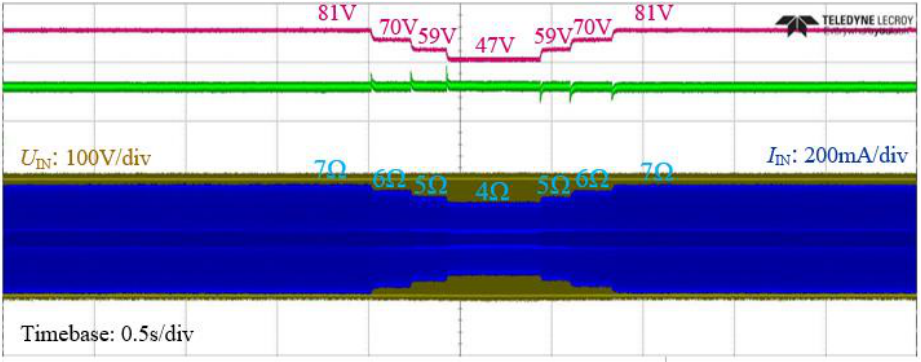
Figure 18. Experimental dynamic response waveforms of multi-load regulation in the CC mode.